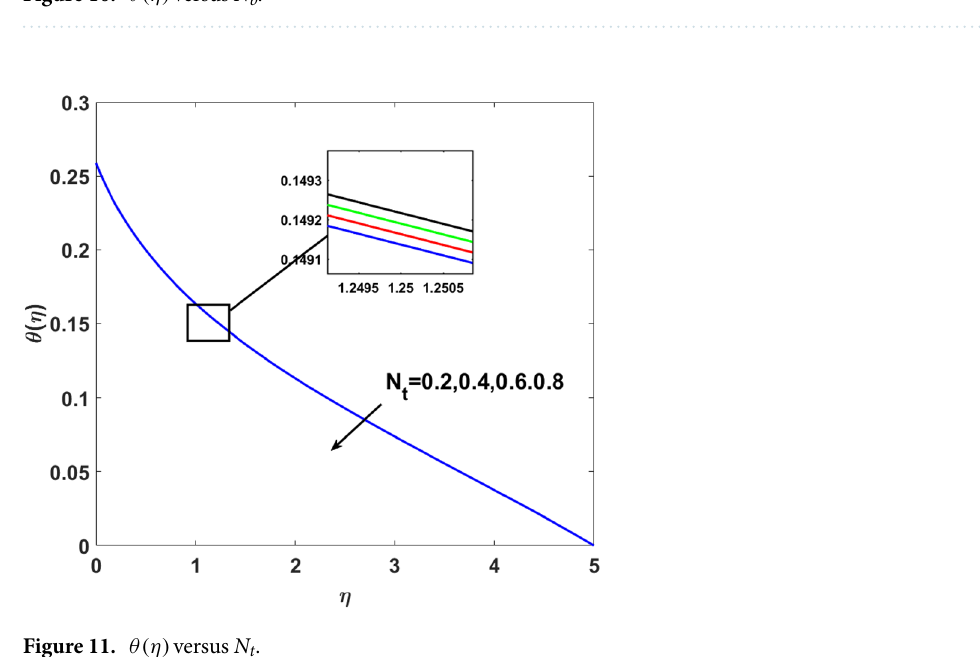
Figure 10. θ(η) versus N b .